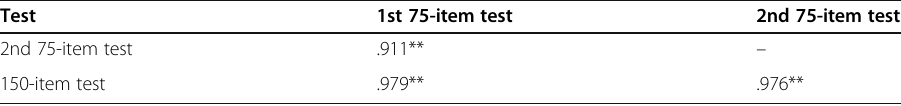
Table 5 Pearson correlation among the 150-item test form and two 75-item test forms Test 1st 75-item test 2nd 75-item test 2nd 75-item test .911**